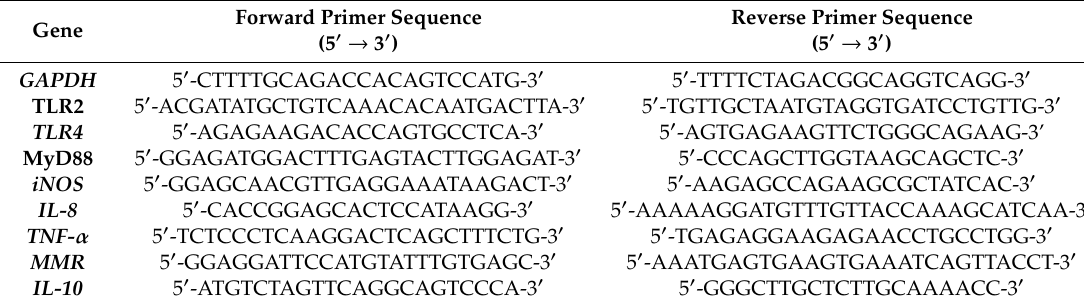
Table 3. RT-PCR primer sequences for interested